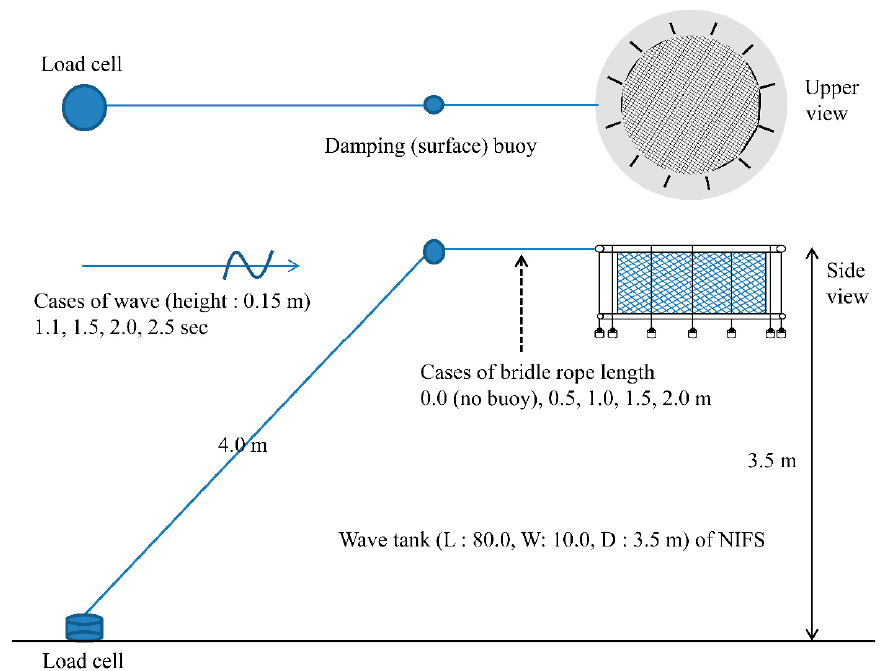
Figure 4. Experimental apparatus for the measurement of the mooring tension in the wave tank (Cha and Lee [12]).